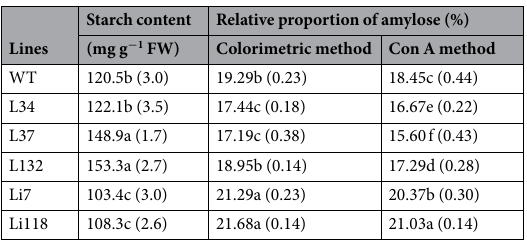
Table 1. Starch content and composition of the transgenic plants and WT a . a Data are presented as the mean of three replicates (starch samples from three different storage roots) with standard deviation given in the parenthesis. The values in the same column with different letters differ significantly at P < 0.05, based on Student’s t Starch content and composition. The starch and amylose contents were quantified in the storage roots of the five transgenic lines and WT (Table 1). The starch content was significantly increased in two of the overex- pression lines (L37 and L132) and significantly reduced in lines Li7 and Li118 compared with WT. To characterize the starch composition, we used the colorimetric method and Con A method to measure the amylose content. The overexpression of IbSSI significantly reduced the the relative proportion of amylose compared with WT when examined by both methods (Table 1) and the colorimetric measurement was about 4.6–10.2% higher than the Con A method. In contrast, the relative proportion of amylose was increased in the RNAi lines. These results demonstrate that IbSSI can impact the content and composition of starch in sweet potato.